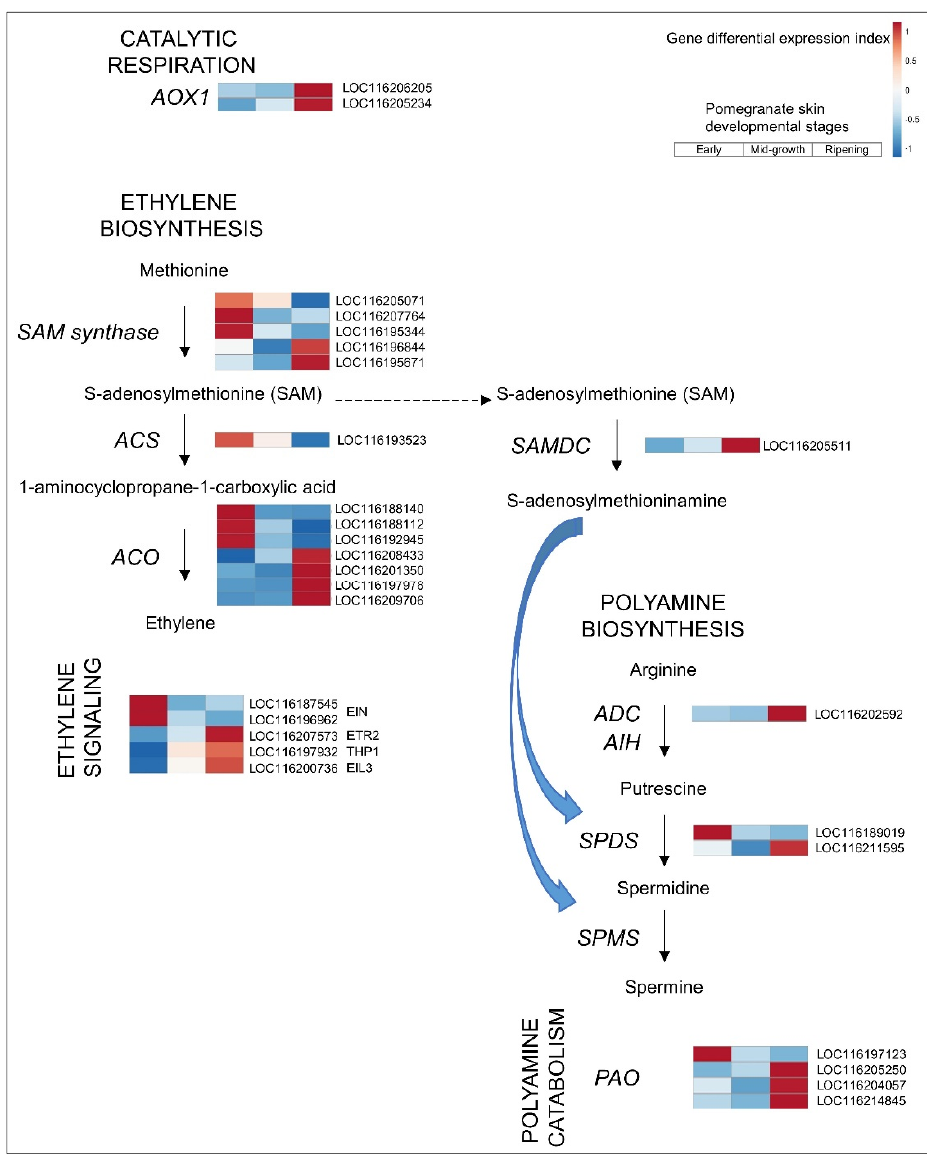
Figure 4. Ethylene and polyamine biosynthesis in pomegranate skin. See Figure 3 legend for details. Expression level values and full gene names are given in Table S6. Expression level values and full gene names are given in Table